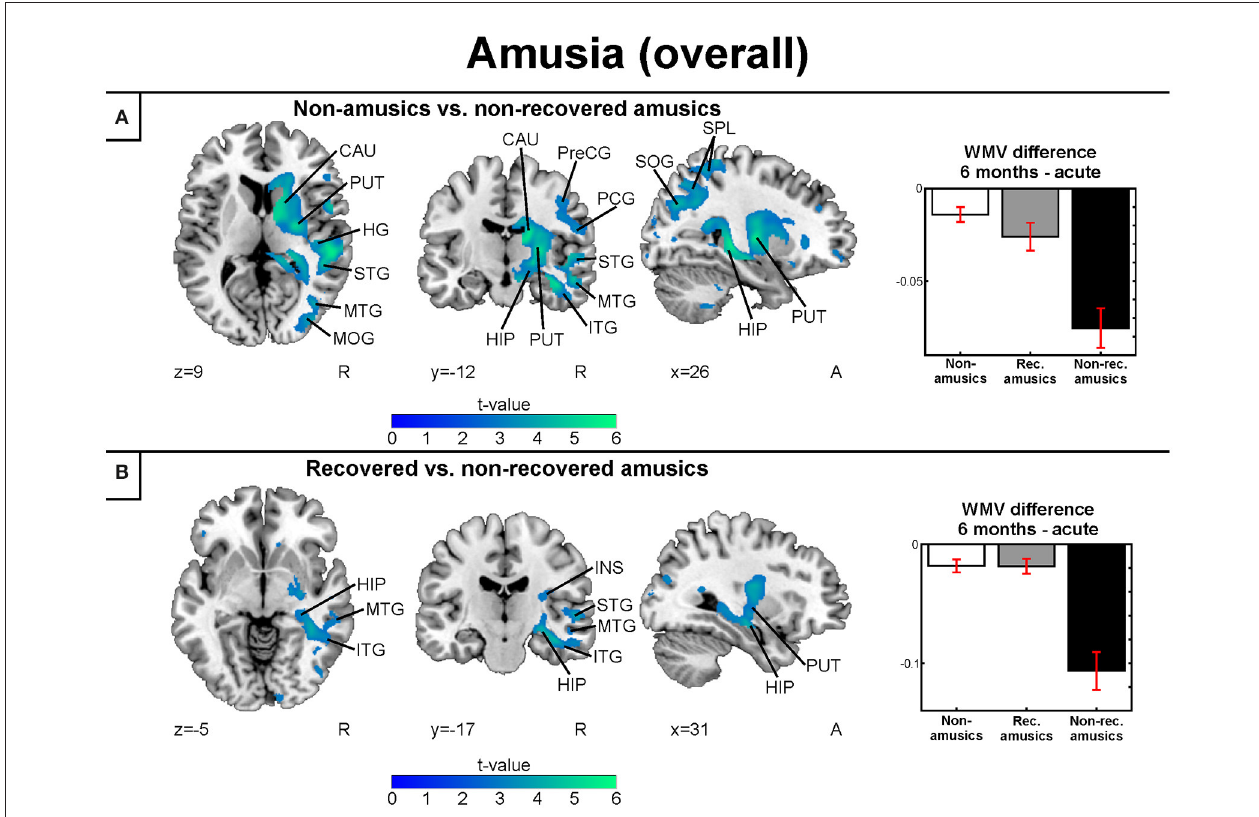
FIGURE 5 | White matter VBM results of pooled analysis: amusia. Time (6 months > Acute) × Group interactions for white matter volume. (A) Non-amusic vs. non-recovered amusics; (B) Recovered vs. non-recovered amusics. Results are thresholded at a whole-brain uncorrected p < 0.005 at the voxel level (extent threshold: k > 100 voxels) using MNI coordinates. Only clusters surviving an FWE-corrected p < 0.05 threshold are reported and labeled (see also Table 3 ). Bar plots for GMV differences in 6 months—Acute in significant clusters ( Table 3 ) are shown: bar = mean, error-bar = standard error of the mean. CAU, Caudate;